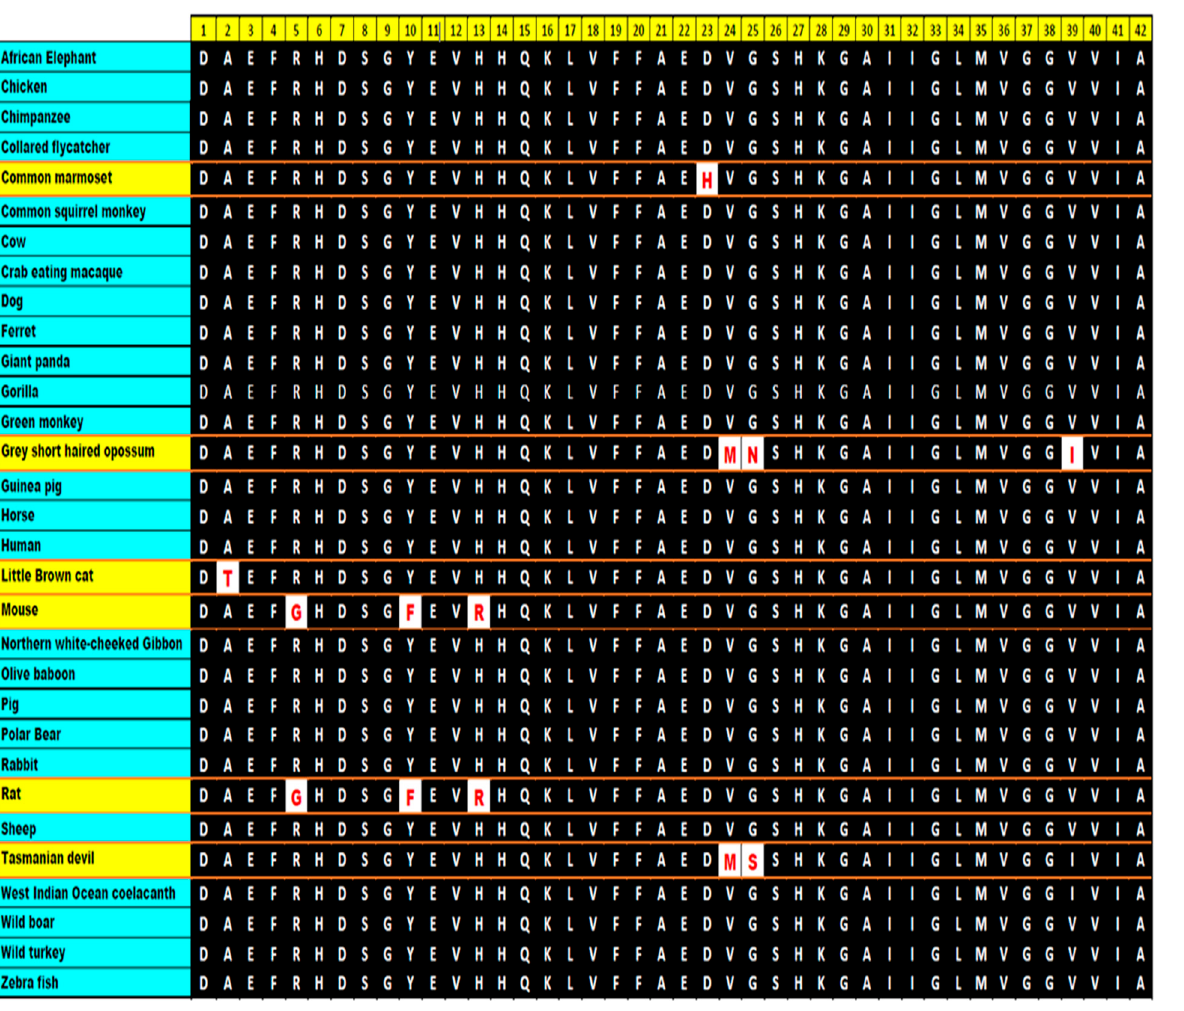
Figure 6. Primary sequence of the A β peptide in different organisms arranged in lexicographical order. The sequence is highly conserved except for rare point amino acid mutations in some organisms.